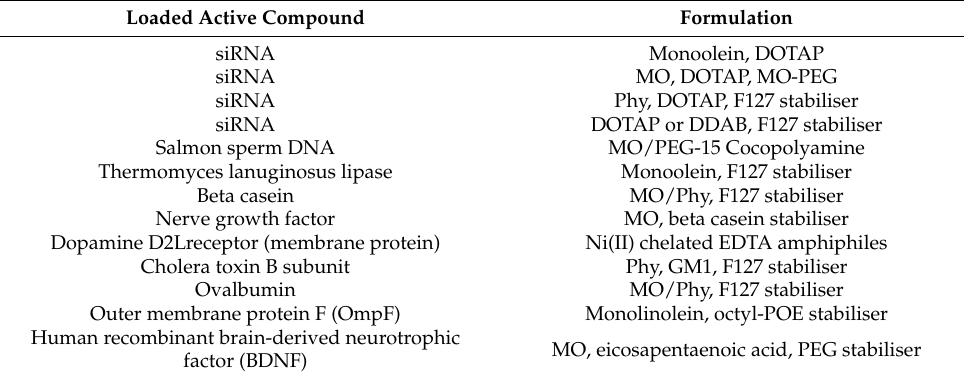
Table 3. Examples of cubosomes loaded with genetic materials and proteins